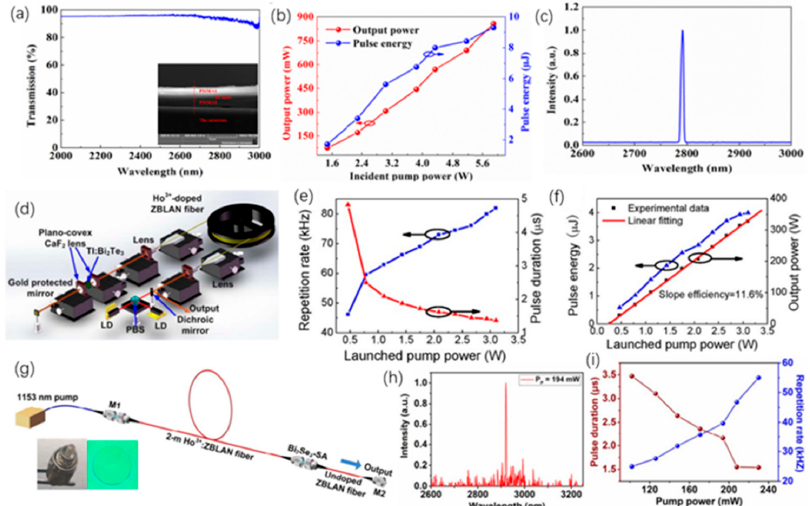
Figure 7. ( a ) Transmission spectrum of Bi 2 Te 3 saturable absorber in the range of 2000–3000 nm. ( b ) The relation curve of output power, pulse energy change curve, and pump power. ( c ) Laser spectrum when the pump power is at the peak value [215]. Copyright 2016 Institute of Electrical and Electronics Engineers Inc. ( d ) Structure diagram of experimental platform of fiber laser. ( e ) When Bi 2 Te 3 is used as a saturable absorber, the relationship between repetition frequency and pulse duration and pump power. ( f ) The relationship of pulse power, output power, and pump power [210]. Copyright 2015 Optical Society of America. ( g ) Structure diagram of experimental platform of Bi 2 Se 3 fiber laser. ( h ) Output spectrum curve of the fiber laser. ( i ) The variation curve of pulse duration, repetition rate, and pump power [216]. Copyright 2018 IEEE.